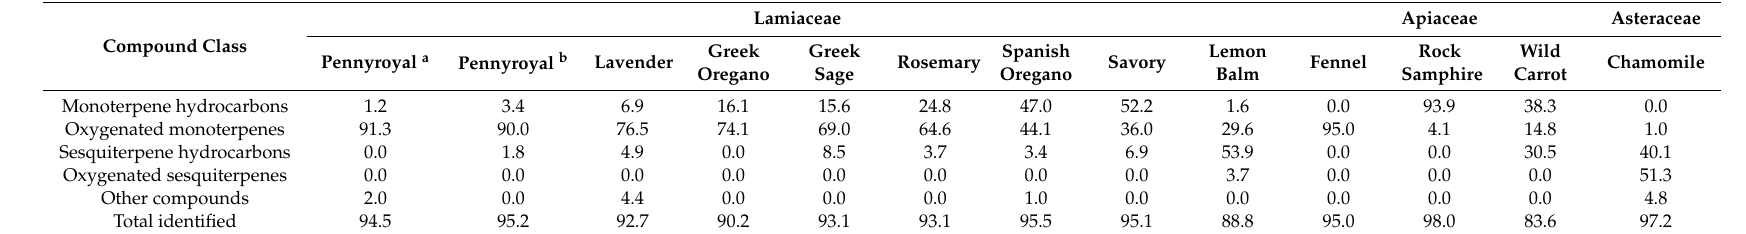
Table 1. Percentage contribution of the various compound classes in the 13 essential oils under